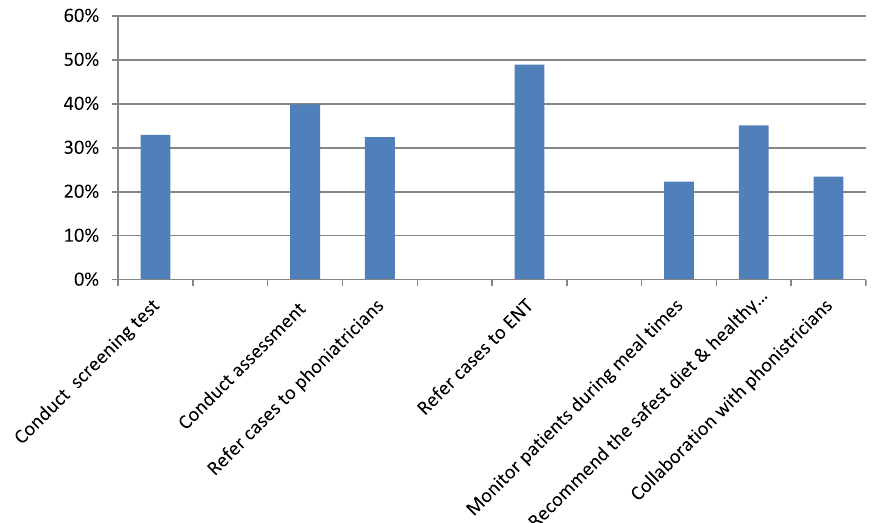
Fig. 1 The percentages of responses of the participants regarding their role in dysphagia management